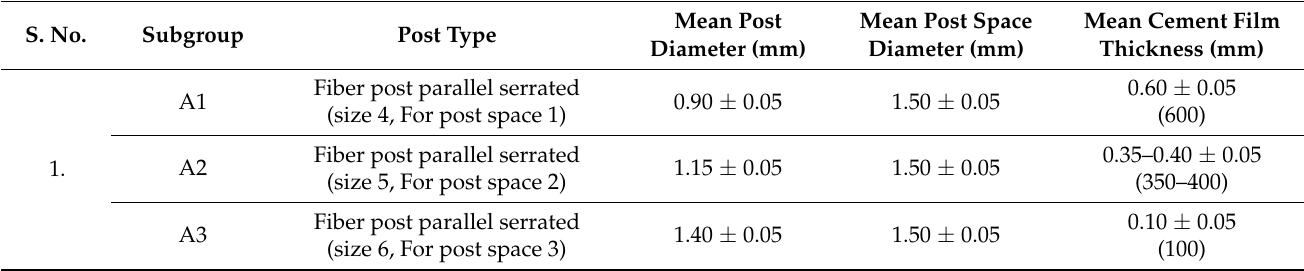
Table 3. Measurement of cement film thickness.